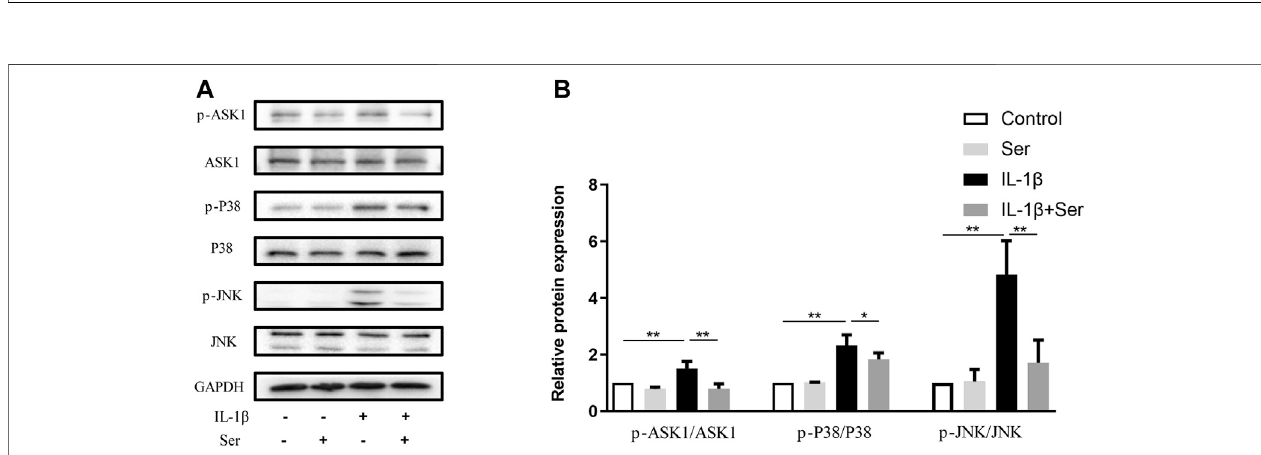
FIGURE4| SerblockstheIL-1 β -inducedASK1/P38/JNKactivationinchondrocyte.CellswereexposedtoL-1 β (10 ng/ml)withorwithout25 μ MSerfor30 min. (A) Westernblot and (B) quantitativeanalysisofASK1/P38/JNKpathwayineachgroup asabove. ASK1,P38andJNK wereused astheexternalcontrol. p p < 0.05, pp p < 0.01, n (cid:2) 3.